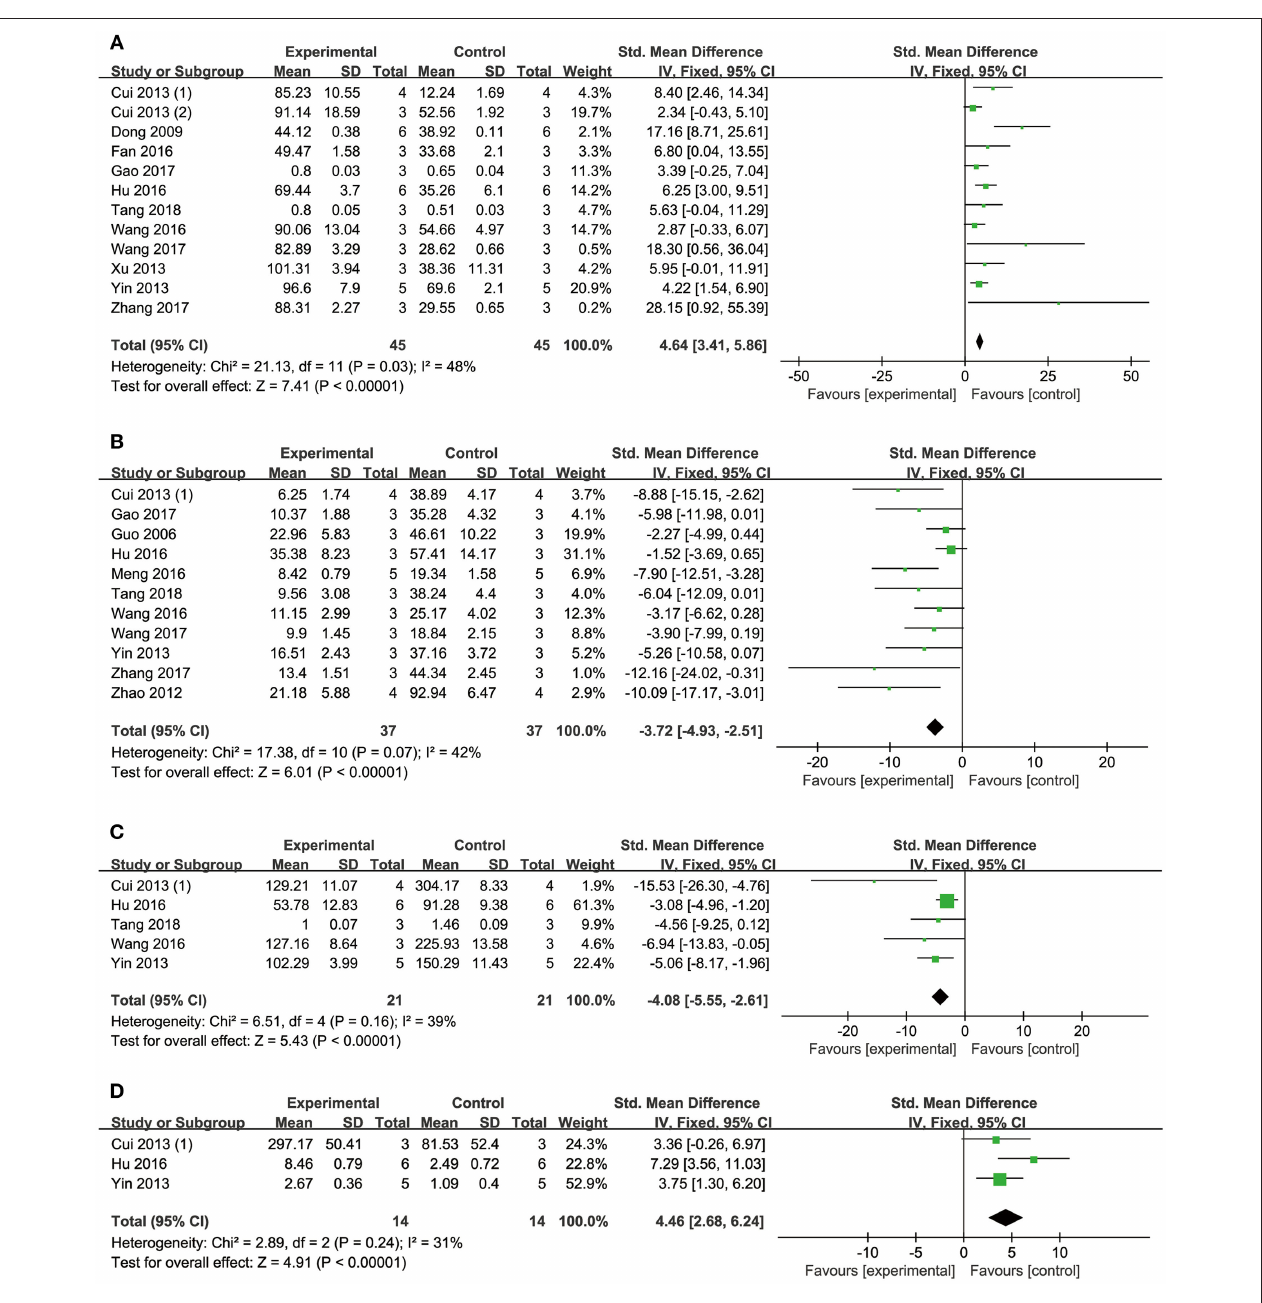
FIGURE 6 | The forest plot: (A) in vitro effects of danshensu for increasing cell viability compared with controls ( n = 45 per group); (B) in vitro effects of danshensu for reducing apoptosis rate compared with controls ( n = 37 per group); (C) in vitro effects of danshensu for reducing LDH compared with controls ( n = 21 per group); ( D) in vitro effects of danshensu for increasing p-AKT compared with controls ( n = 14 per group). LDH, lactate dehydrogenase; p-AKT, phosphothreonine kinase.